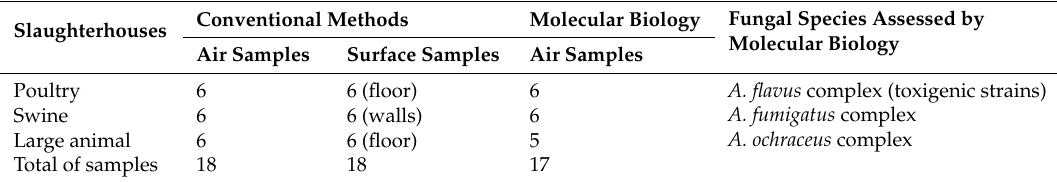
Table 2. Number of samples collected and the fungal species